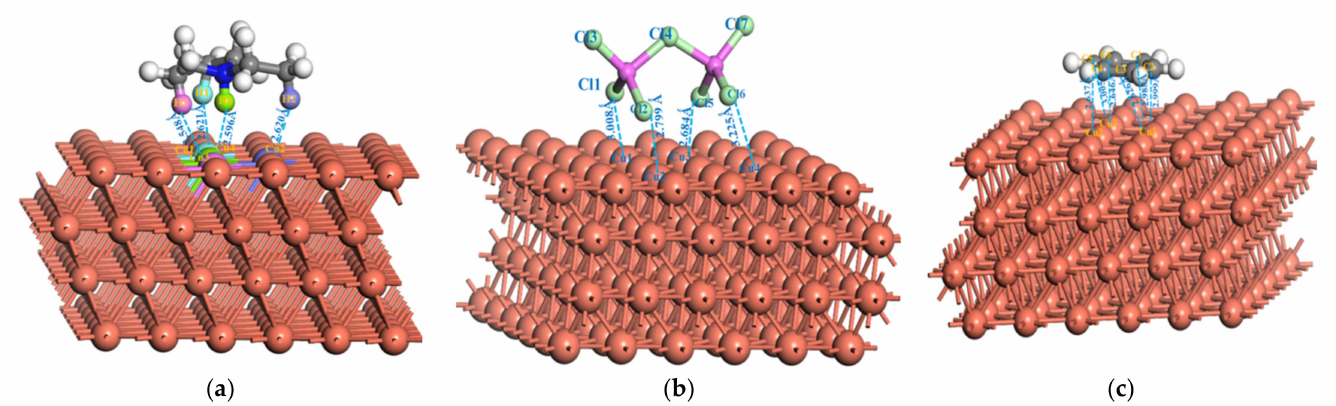
Figure 8. Optimized adsorption configurations of ions adsorbed on Cu(111) surface for ( a ) Et 3 NH + ; ( b ) Al 2 Cl 7 − and ( c ) C 6 H 6